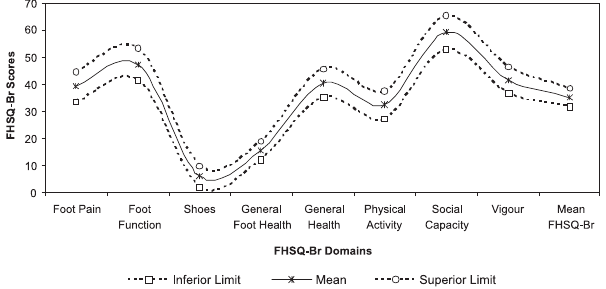
Figure 1 - Mean FHSQ-Br score of the three interviews and inferior and superior limits of the confidence